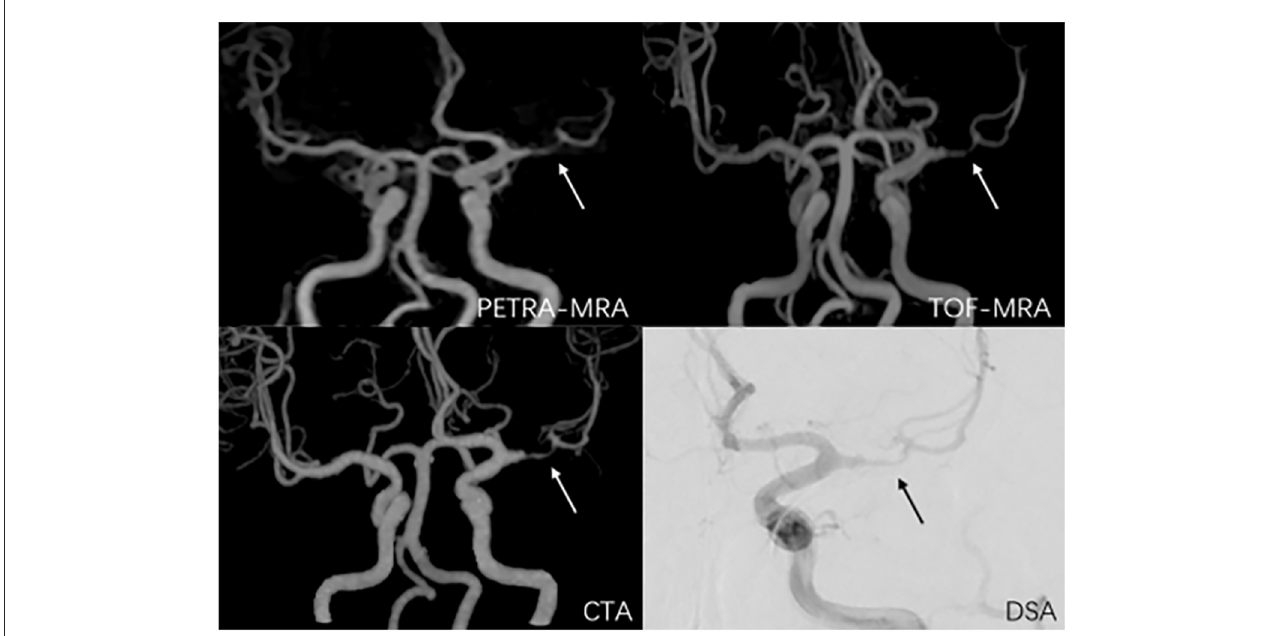
FIGURE4 A 38-year-old man with symptomatic left middle artery stenosis. The arrow marks the location of the lesion. The degree of stenosis was 80.9% on PETRA-MRA, 89.1% on TOF-MRA, 88.3% on CTA, and 82.3% on DSA. Lesion length was 6.98mm on PETRA-MRA, 7.41mm on TOF-MRA, 7.83mm on CTA, and 6.5 4mm on DSA.